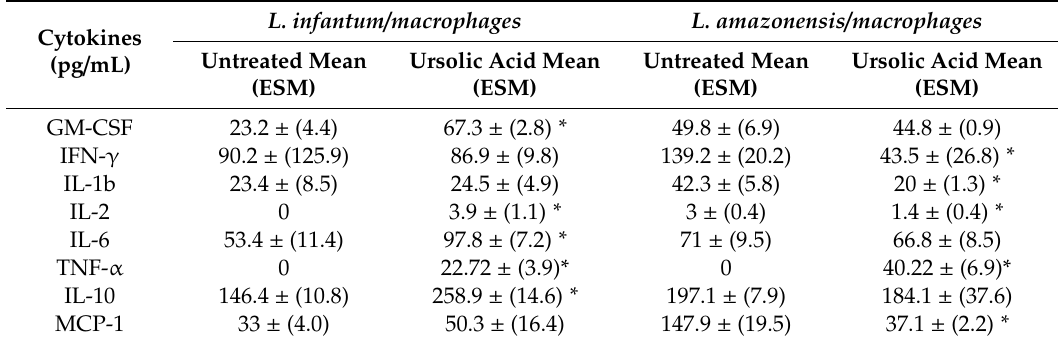
Table 6. Quantification of cytokine production in Leishmania -infected macrophages untreated and treated with UA tested at IC 50 values, respectively, for each parasite